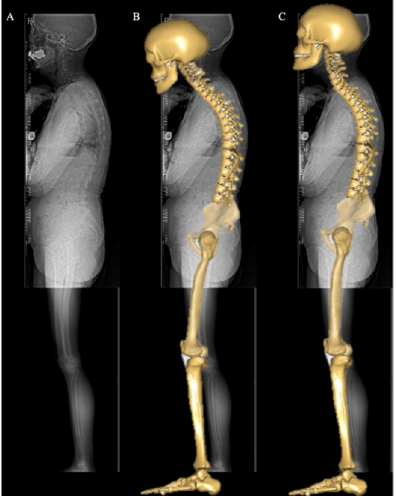
Figure 4. A patient’s full body lateral radiograph, and musculoskeletal model (MSM) images before and after cervical spine alignment correction. ( A ) Full-body lateral radiograph of a patient. ( B ) A modified MSM with altered thoracolumbar, pelvic, and lower-extremity alignment and unaltered cervical spine alignment. The model’s cranial location was not matched to the patient alignment.